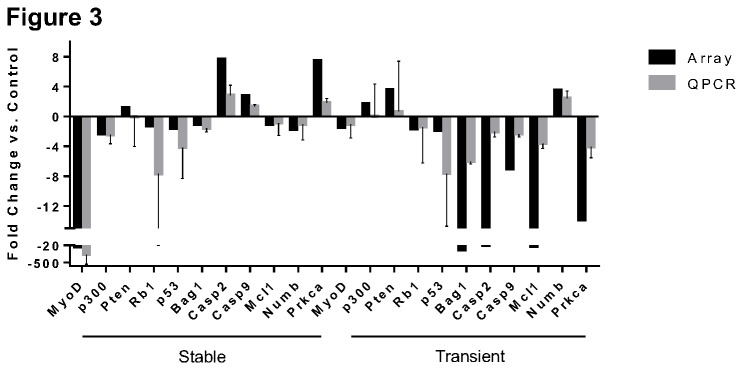
Array Confirmation.Confirmation of targets from gene array by Quantitative PCR verifies array expression values. QPCR of selected genes that showed variation in expression in arrays were selected and tested with three independently isolated single cell clones using the same shRNA as the array(S36), Transient transfections were carried out in triplicate with the same shRNA , and control cells received the scrambled control plasmid (mean + S.E.M., n = 3) for verification. For each gene, the change in expression matched that of the array in both types of transfections.